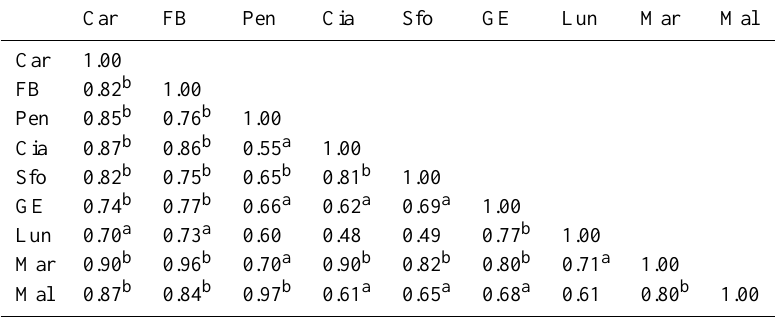
Table 3. Correlation matrix of B a for nine Italian glaciers. Car FB Pen Cia Sfo GE Lun Mar